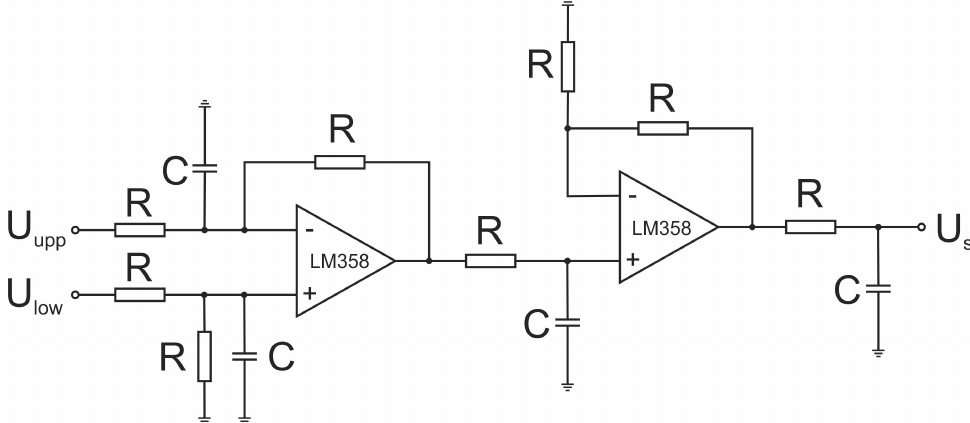
Figure 9. Schematic representation of a